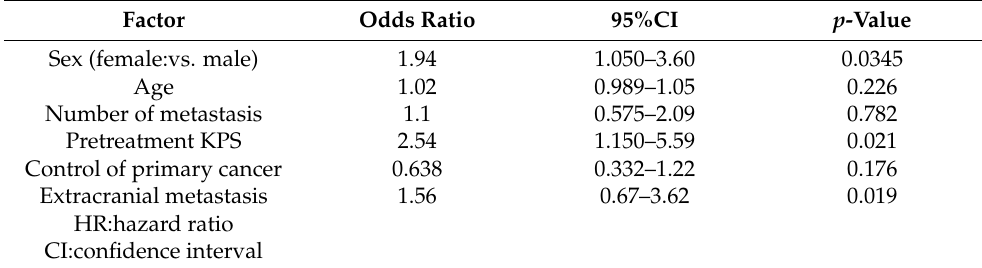
Table 3. Logistic regression analysis for long-term